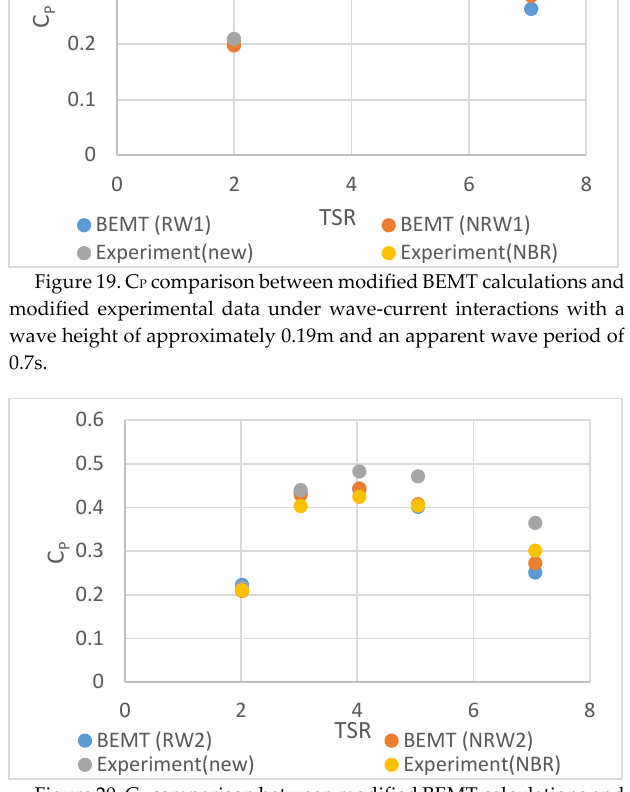
Figure 20. C P comparison between modified BEMT calculations and modified experimental data under wave-current interactions with a wave height of approximately 0.09m and an apparent wave period of